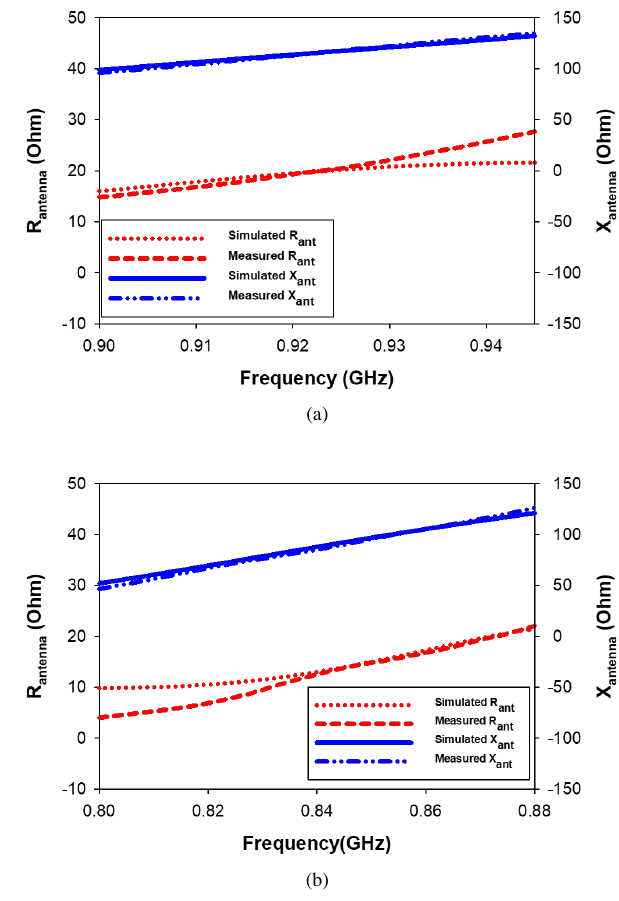
FIGURE 9: Simulated and measured antenna impedance: (a) for 915 MHz, (b) for 868